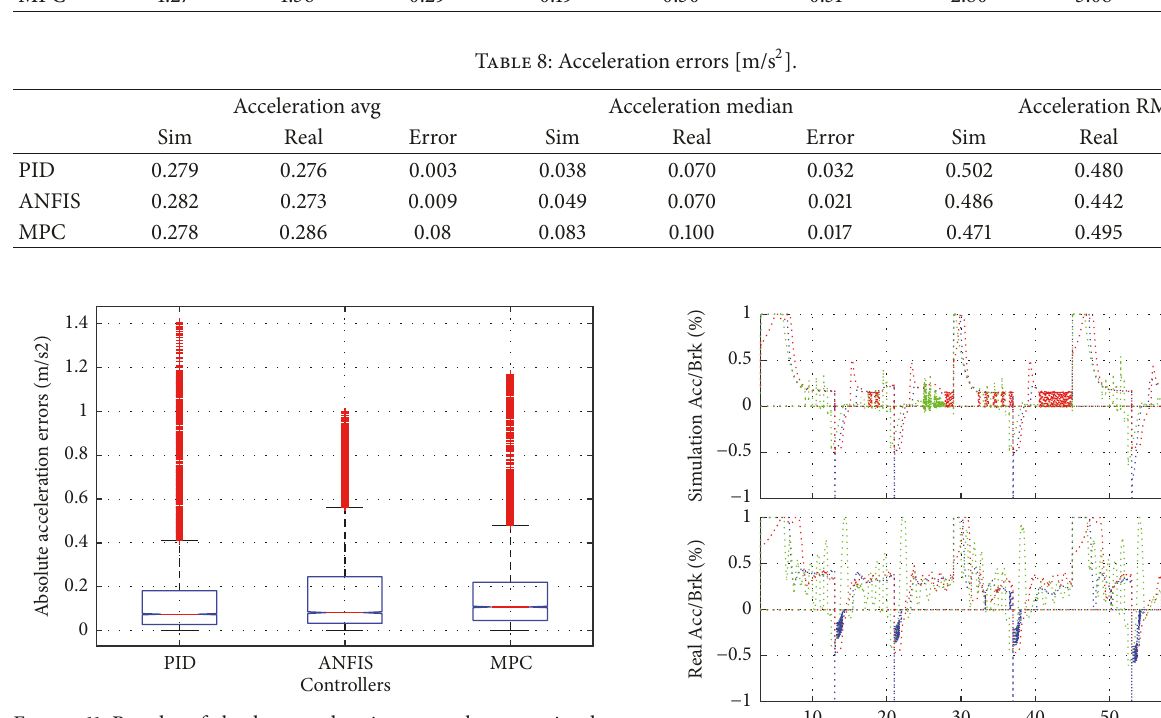
Figure 11: Boxplot of absolute acceleration errors between simula- tion and real platform [m/s 2 ].